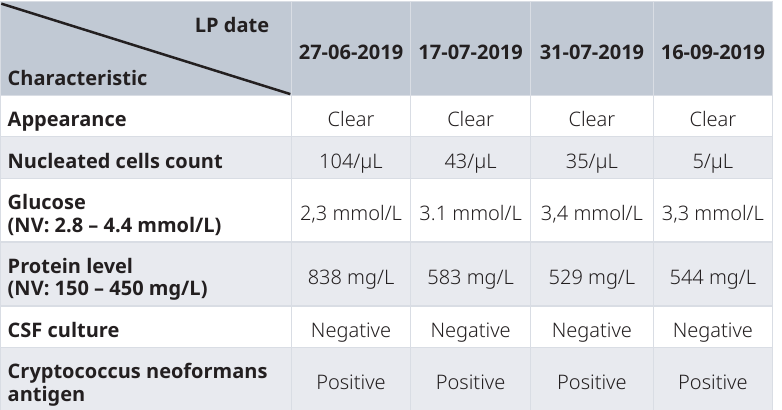
Table 1. Cerebrospinal fluid profile evolution throughout treatment. CSF – Cerebrospinal fluid. LP – Lumbar puncture. NV – Normal value.